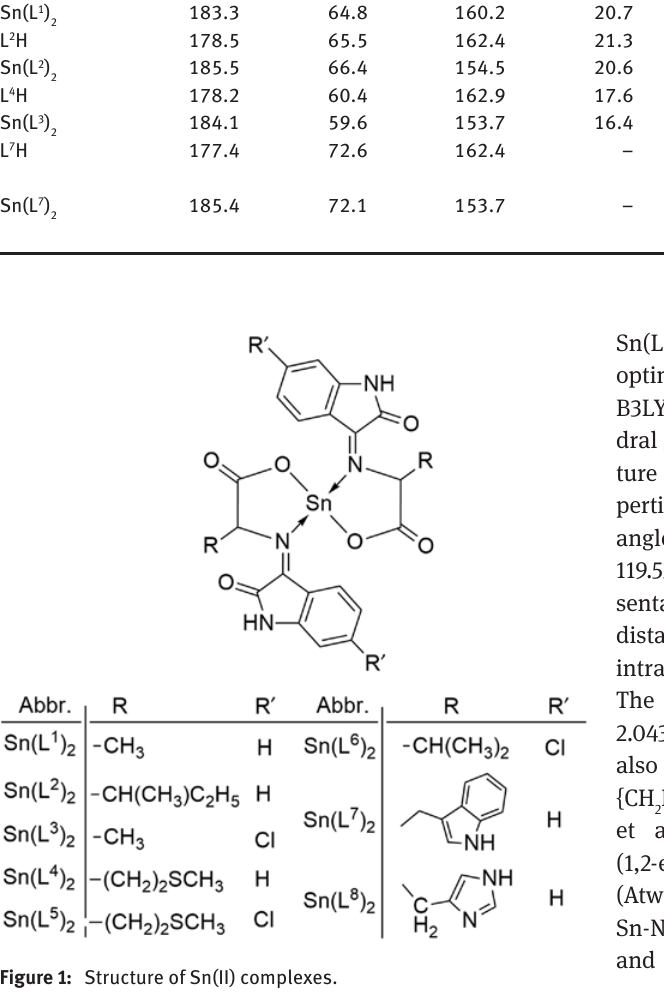
Aromatic carbons